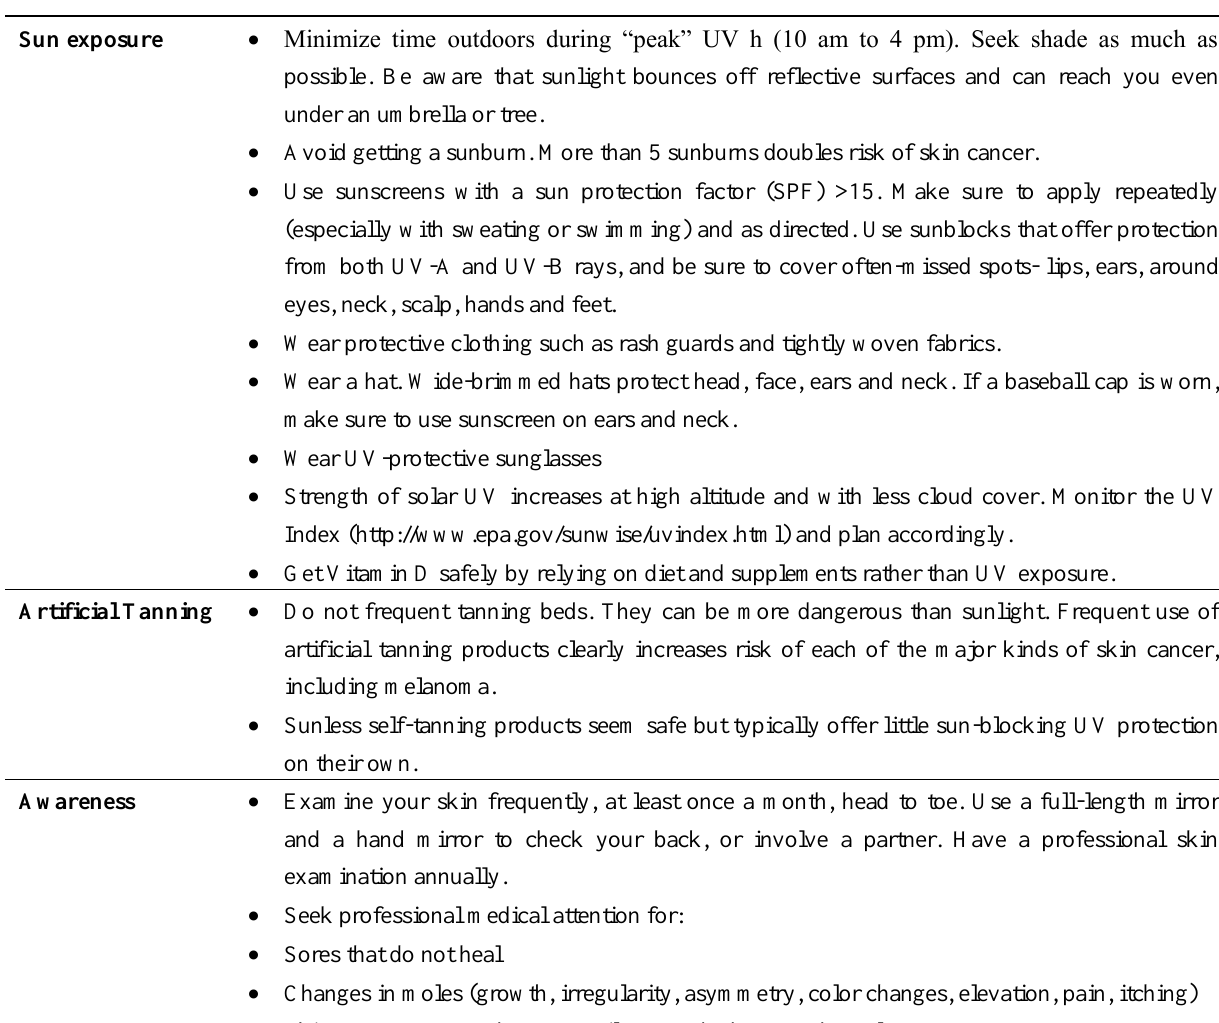
Table 2. UV Safety